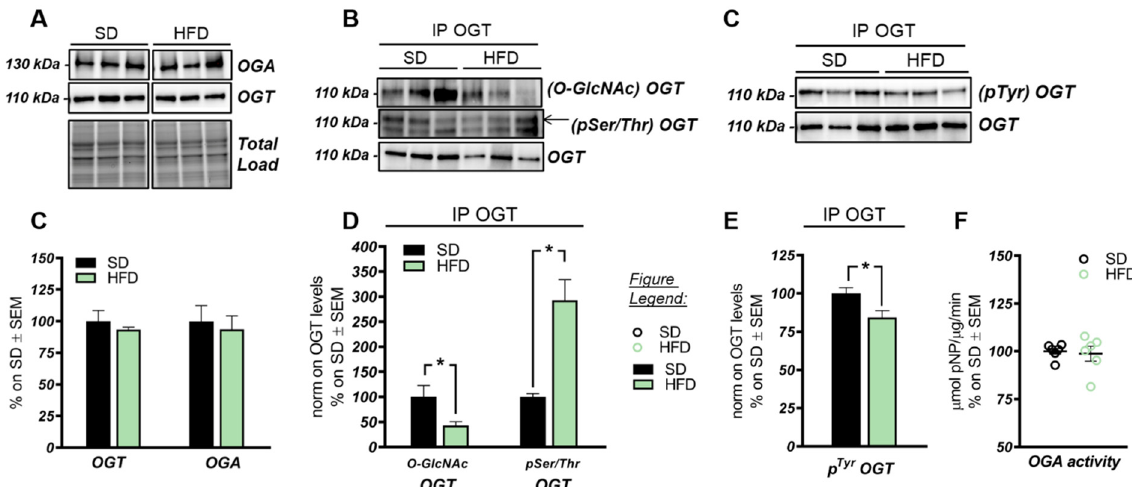
Figure 2. OGT/OGA functionality in the hippocampus of HFD mice. ( A , C ) OGT and OGA protein levels in HFD mice hippocampi. No relevant changes were observed in the protein expression levels of the enzymes controlling O-GlcNAc cycling. Representative blots are reported in ( A ). ( B , D ) Evaluation of OGT’s posttranslational modifications(PTMs) by immunoprecipitation analysis. A significant reduction in O-GlcNAc OGT/OGT levels, together with a consistent increase in its pSer/Thr OGT/OGT levels, were observed in the hippocampi of HFD mice in comparison to the same brain region from SD mice. Representative blots are reported in ( B ). ( C , E ) Evaluation of OGT phosphorylation on Tyr residues. A significant reduction was observed in HFD mice compared to respective SD group, suggesting an alteration of OGT functionality. Representative blots are reported in ( C ). ( F ): OGA activity assay. No changes were observed in OGA enzymatic activity between the two experimental groups. Number of animals for each condition were as follows: n = 6/group for Western blot and OGA assay analysis while n = 3/group was used for immunoprecipitation analysis. All bar charts reported in ( C – E ), and ( F ) show mean ± SEM. * p < 0.05 using Student’s t test.